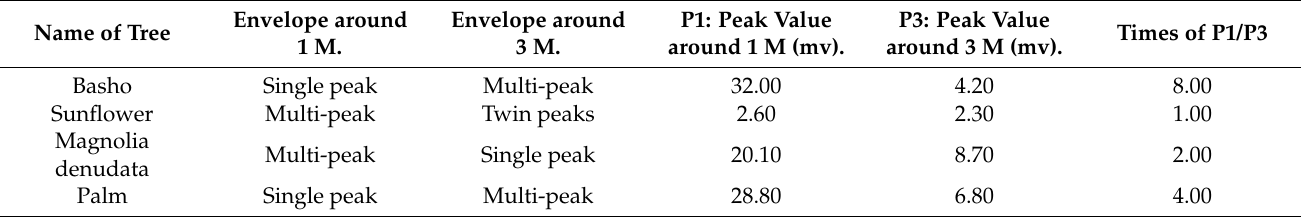
Table 4. Energy distribution of resonance peak in ultrasonic spectrum of plant